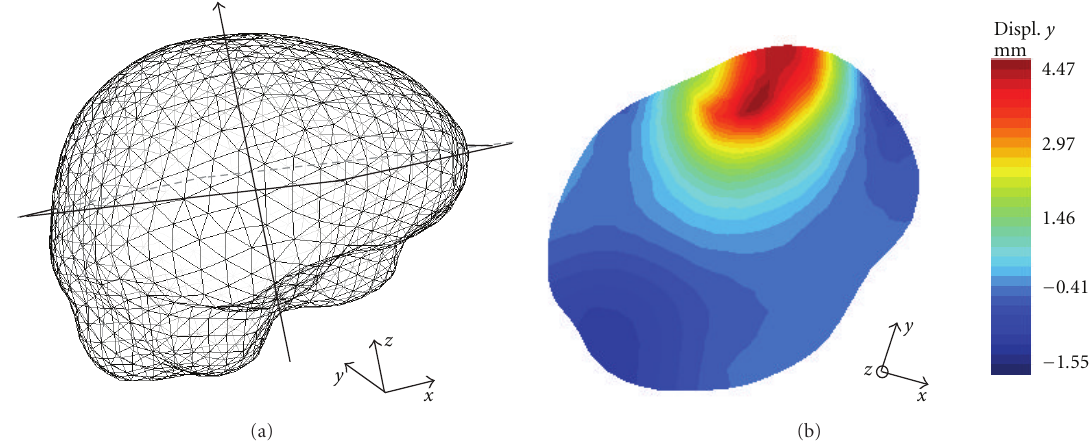
Figure 3: Result of the biomechanical model deformation for brain shift modeling (first patient case). (a) External surface mesh of the biomechanical model with the location of the slice considered in (b). (b) Selected slice of the biomechanical model with color levels corresponding to the displacements along the y -axis, which is the main direction of the brain shift for this patient